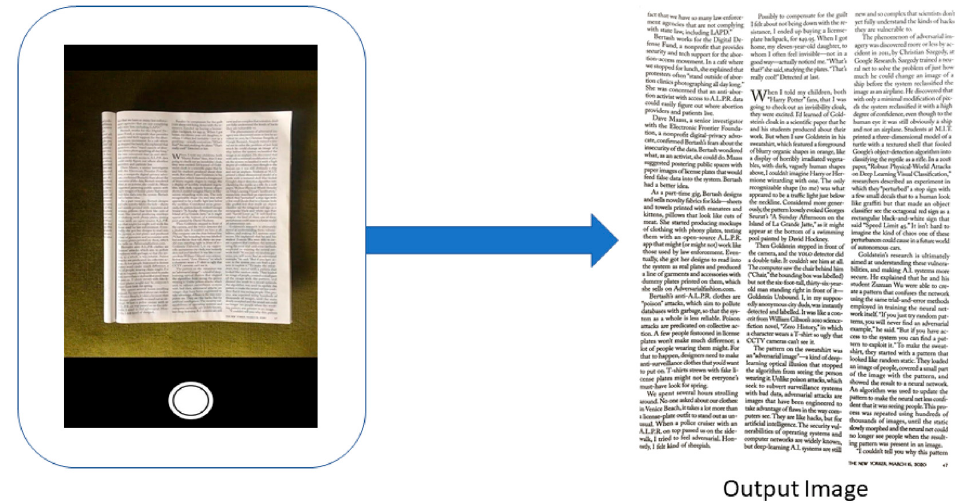
Figure 7. CleanPage’s simple user interface (UI). One button-tap results in the output image.